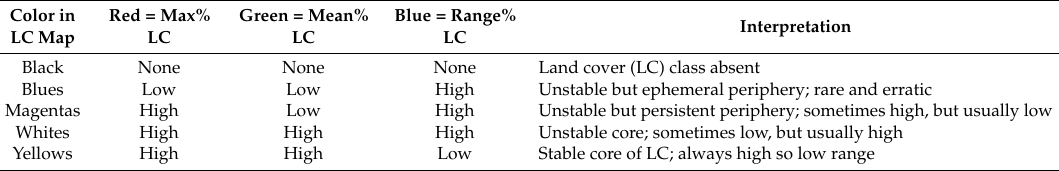
Table 2. Interpretative legend for Figure 1 that display IGBP MODIS 0.05 ◦ land cover variation from 2003–2010 in the study region. The table shows how the color in the LC map (Figure 1) arises from the false color composite of red, green, and blue color planes that display, respectively, the maximum percentage of LC class, the average percentage of LC class, and the range of percentages of LC class over the study period. Source: